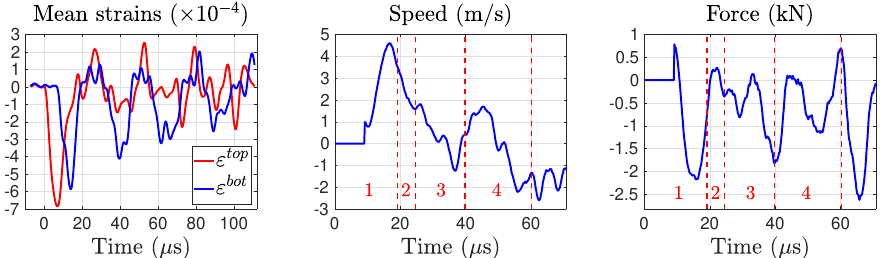
Fig. 2. Gauge data and measured speed and force at the base of the indent cone. Four steps (split by dashed vertical lines) can be distinguished thanks to the fast camera: 1- Dynamic indentation & elastic phase, in-depth propagation; 2- Star-crack opening; 3- Bouncing; 4- Secondary crack growth. Gauge measurements are represented on Fig. 2. The speed and force are determined at 1.1 mm from the glass surface. An initial peak in force and velocity can be noticed at the beginning of impact, at about 15 µ s. If the velocity signal does show a double load, with a second peak at 45.4 µ s, the latter is more difficult to observe on the force curve. The crack formation is also monitored with a Shimadzu ® HPV-X2, ultra-high speed camera, with an ac- quisition rate of 1 to 5 Mfps and a definition of 400 × 250 pixels. Thanks to this monitoring, the crack formation is fully captured, and a first crack opening is identified between 19.2 µ s and 24.6 µ s, followed by a bounce of the indent up to 39.8 µ s. The crack branches secondary growth lasts for 20 µ s. The final crack geometry is reached at 60.2 µ s. This branches evolution is displayed on Fig.